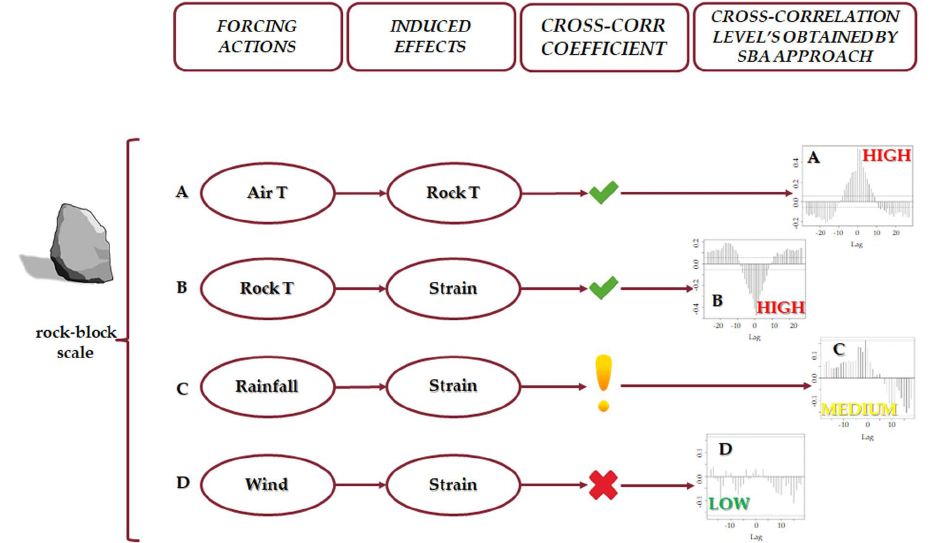
Figure 13. Results from the SBA experienced at the Acuto test-site with associated severity levels determined by cross-correlating causative forcing actions and the induced e ff